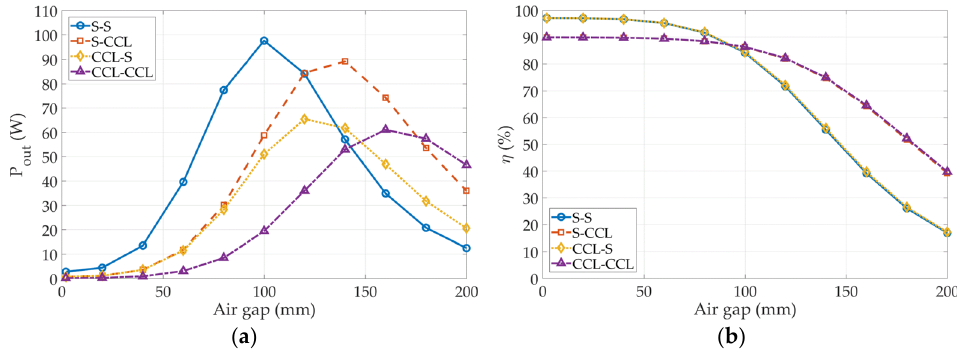
Figure 16. ( a ) Transmitting power and ( b ) power transfer efficiency of topologies at various air gaps.